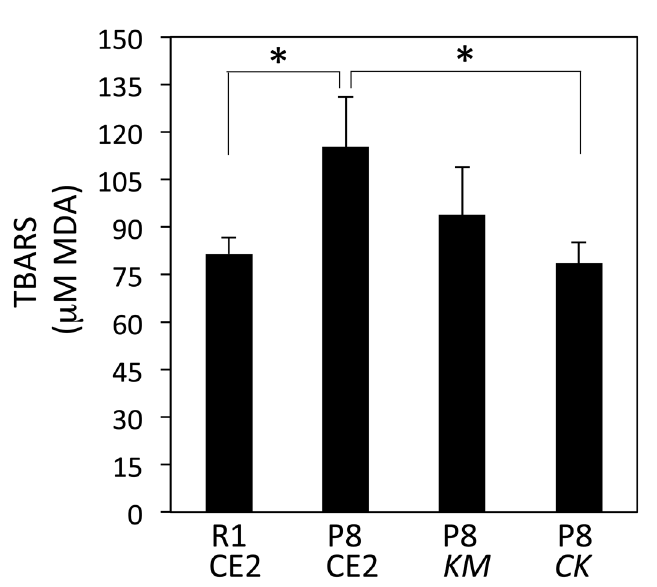
Fig 4. Level of TBARS in serum in 7-month-old senescence-accelerated mice. TBARS levels in serum were measured (R1 CE2, n = 12; P8 CE2, n = 12; P8 KM , n = 12; P8 CK , n = 11). Results are expressed as mean ± SE. * p < 0.05, vs . P8 CE2.